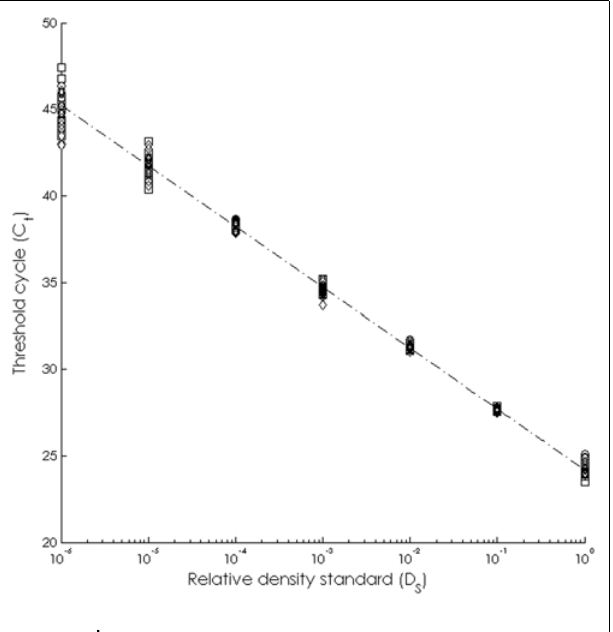
FIGURE 1 | Standard curve representing the relationship between the relative concentration of theWS-RLO DNA ( D S ) and the threshold cycle ( C t ) determined by the real-time qPCR assay .